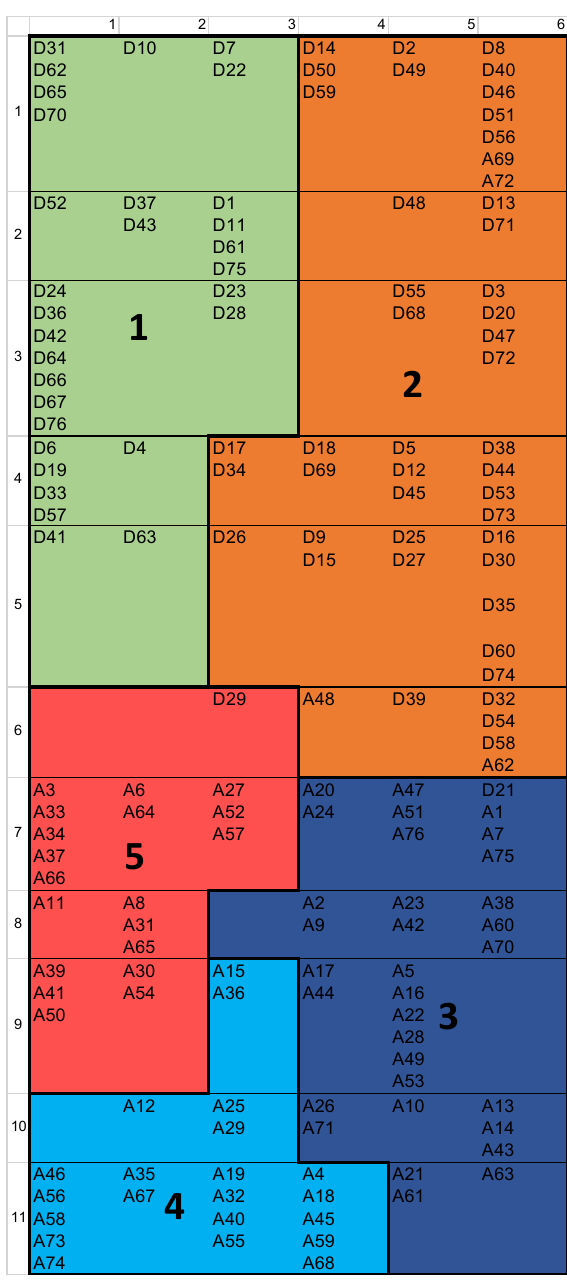
Figure 2. SOM. Figure 2.